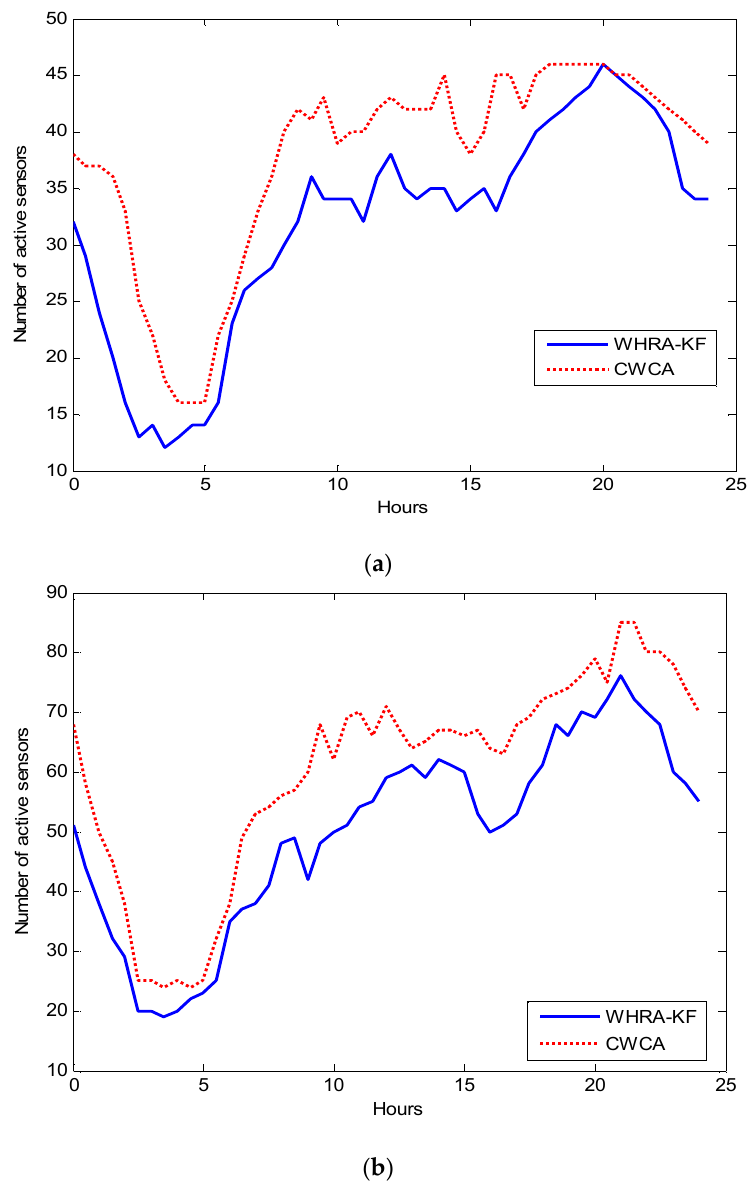
Figure 13. Active sensors over a period of a day on average, ( a ) 50 n ; ( b ) 100 n .